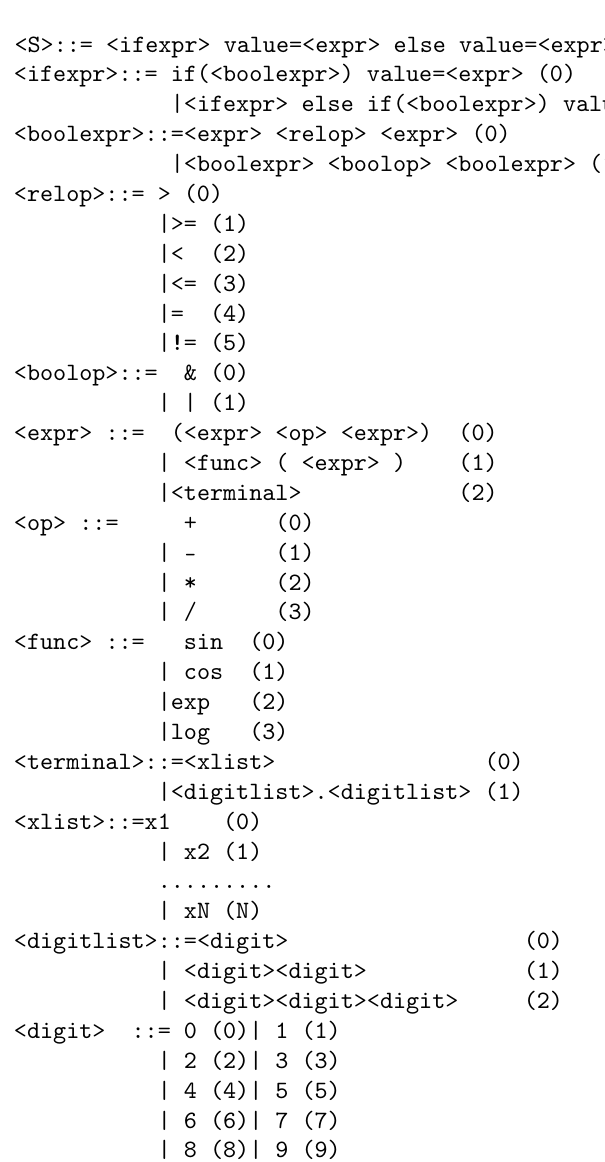
Figure 1. The BNF grammar for the proposed